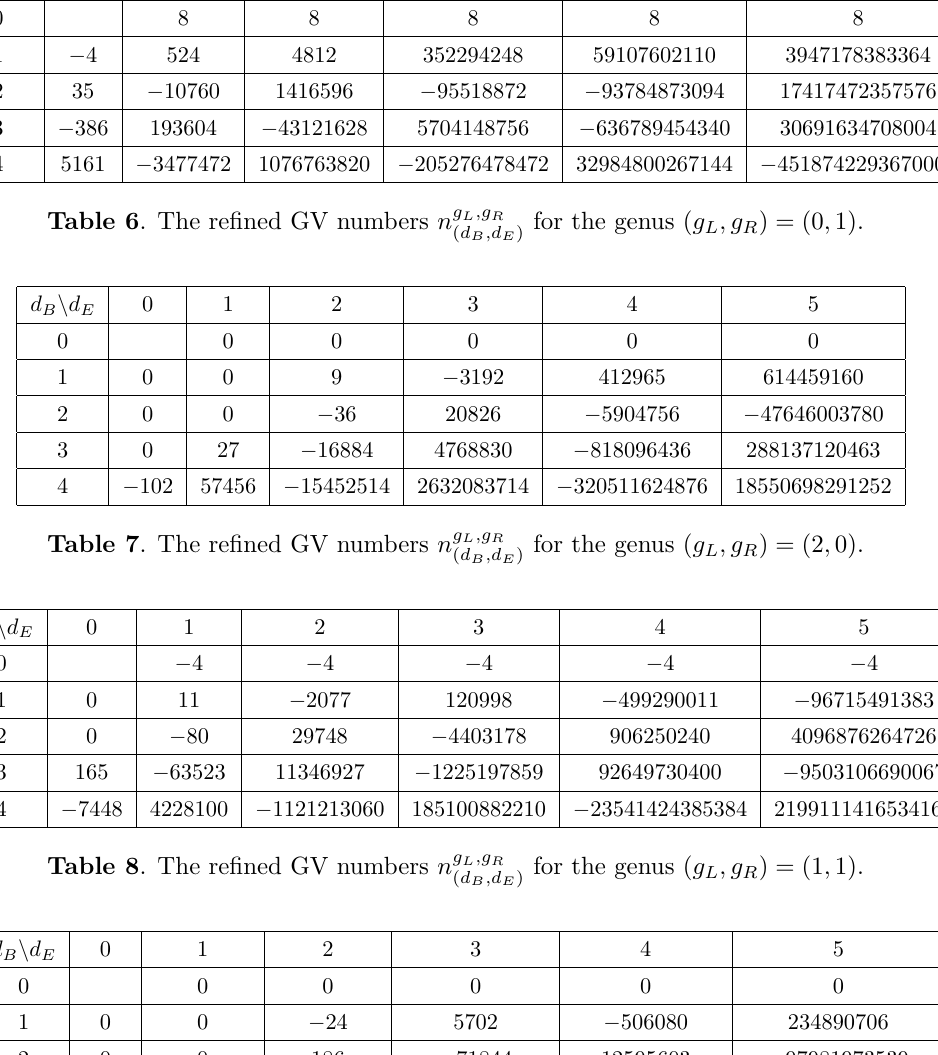
Table 9 . The refined GV numbers n g L ,g R